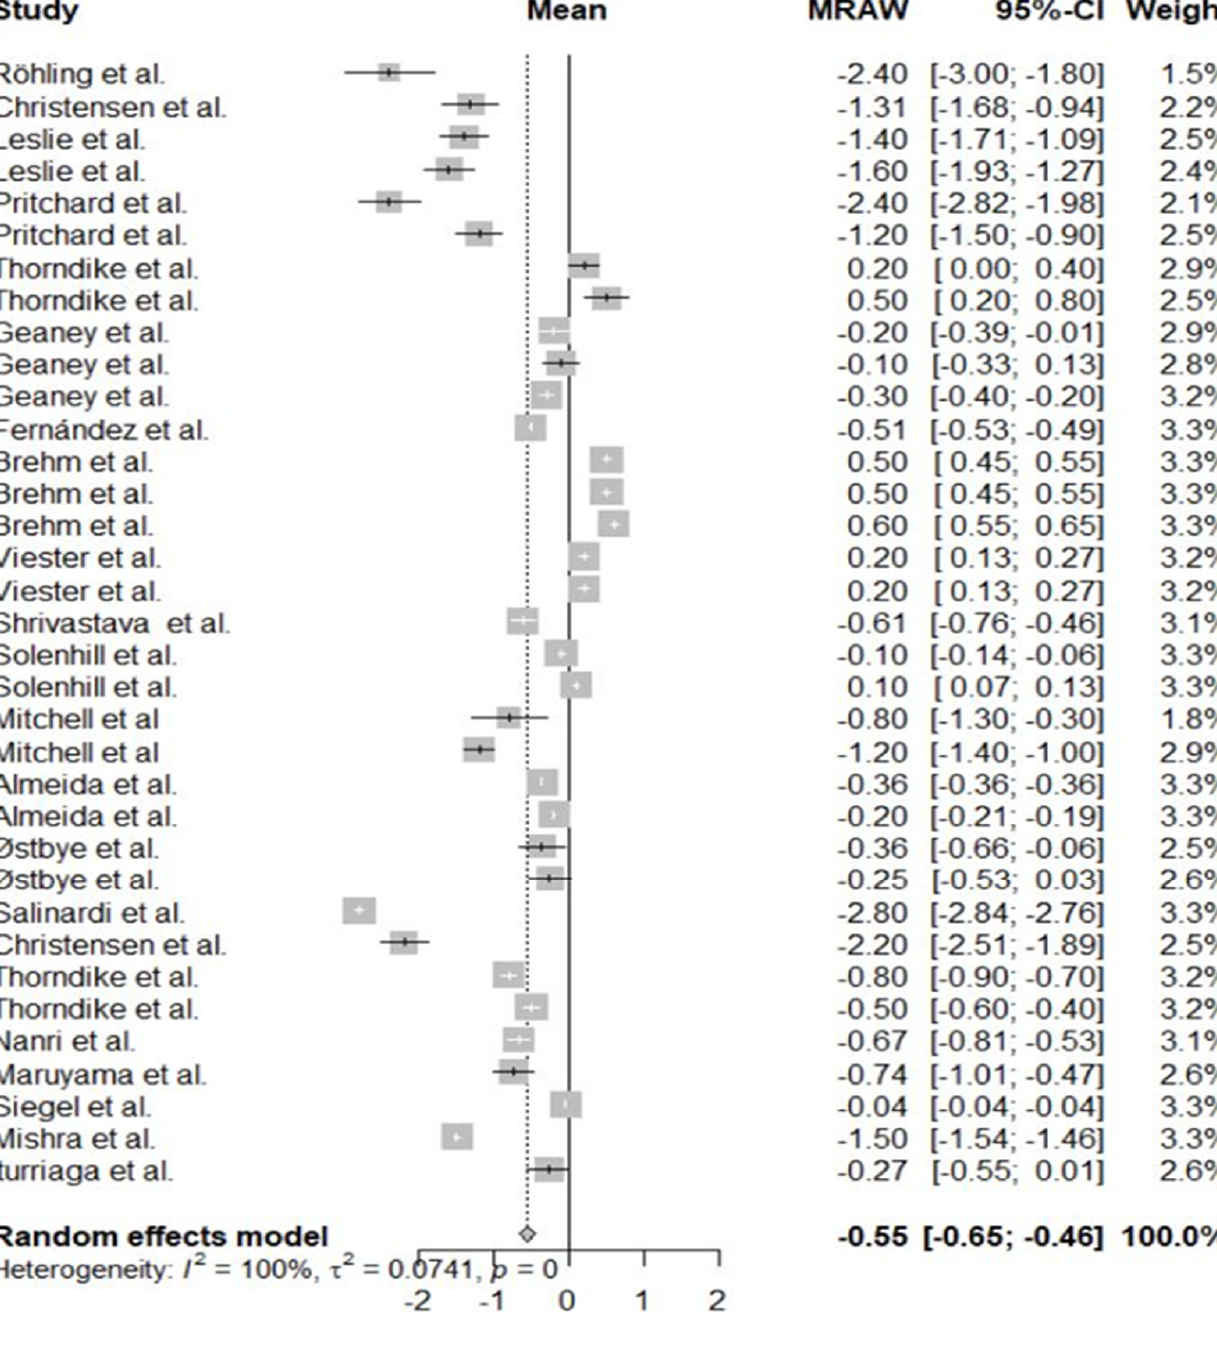
Table 3. Summary leave-one-out, Baseline of Body Mass Index and interventions. ID